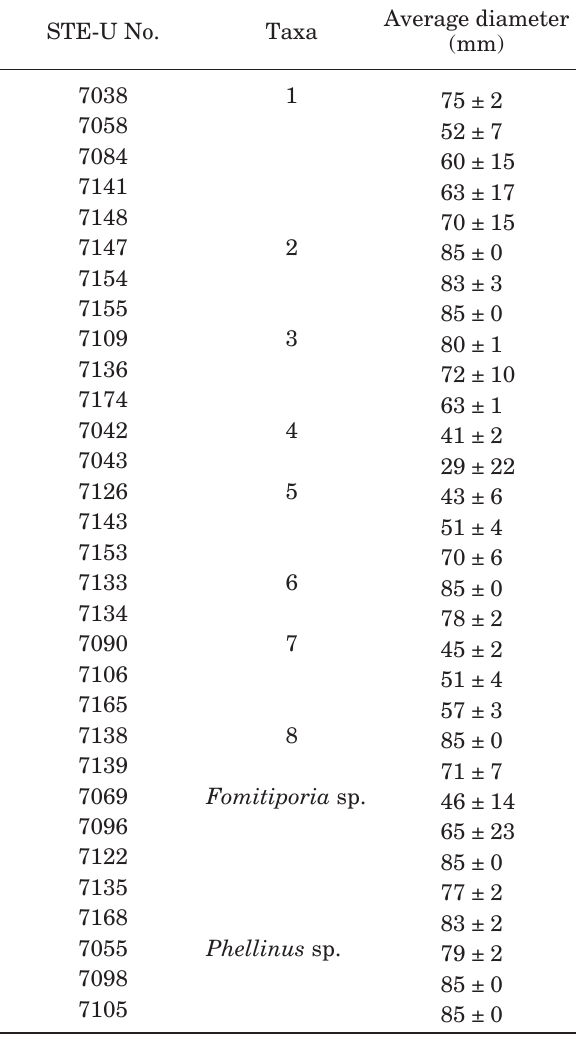
Table 4. Colony diameters of the basidiomycete isolates grown on PDA at 25 o C after 14 days.